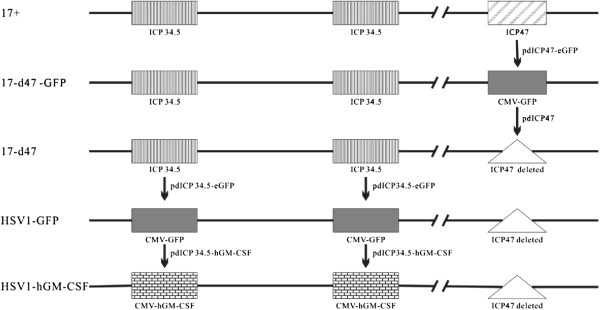
Schematic construction of oncolytic HSV1-GFP and HSV1-hGM-CSF. The two oncolytic HSV1 vectors were developed from 17+ strain. First, the ICP47 gene was removed from the virus genome by pdICP47-eGFP and pdICP47. Then, the GFP expression cassette from pdICP34.5-eGFP was inserted into both sites for ICP34.5 genes to generate HSV1-GFP. The hGM-CSF expression cassette from pdICP34.5-hGM-CSF was used to replace GFP expression cassettes in HSV1-GFP to create HSV1-hGM-CSF.